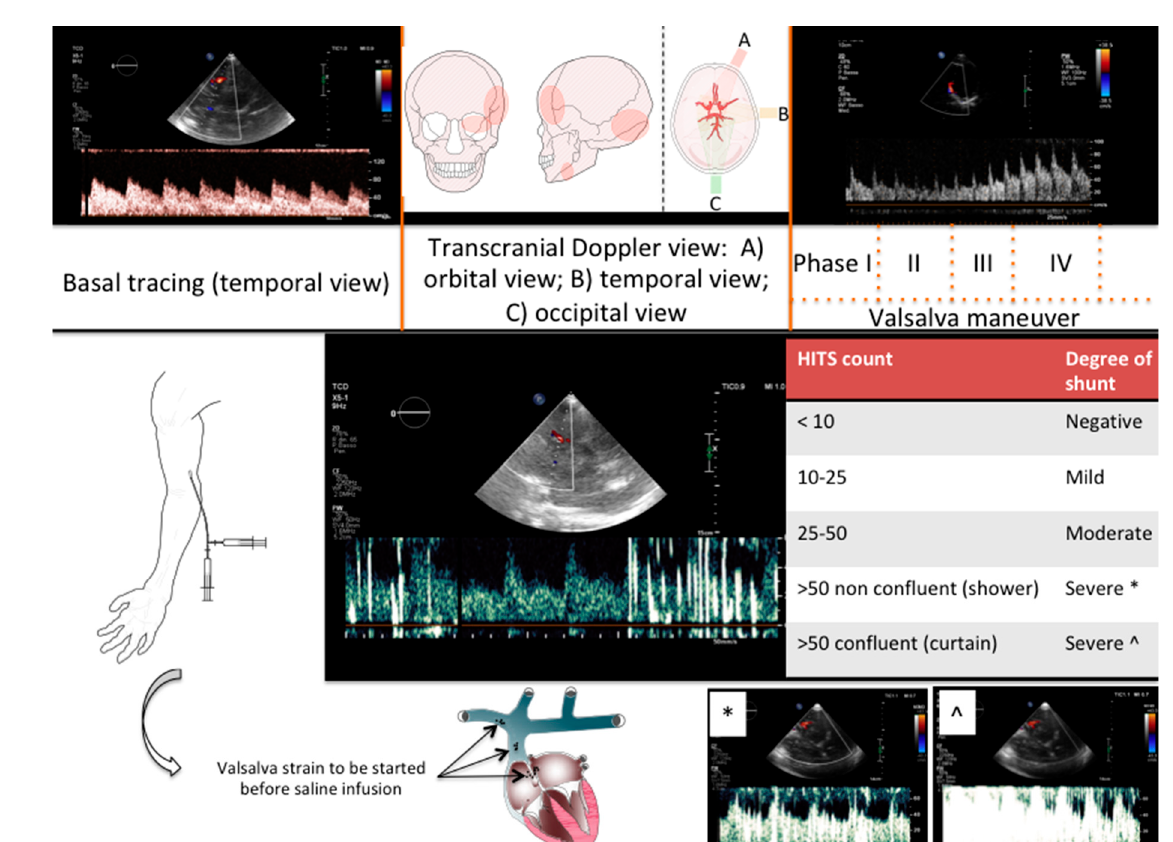
Figure 5. Transcranial Doppler Study. Top row (left to right) shows basal TCD tracing, routine transcranial acoustic window and Valsava maneuver effect on TCD tracing. Bottom row shows suggest site for peripheral vein cannulation, mechanism of Valsalva-mediated effect on PFO-associated paradoxical embolization. The central tracing depicts a moderate shunt. Suggested threshold for TCD shunt grading with pertinent samples tracings are also presented. HITS: High Intensity Transient Signals; TCD = Trans-Cranial